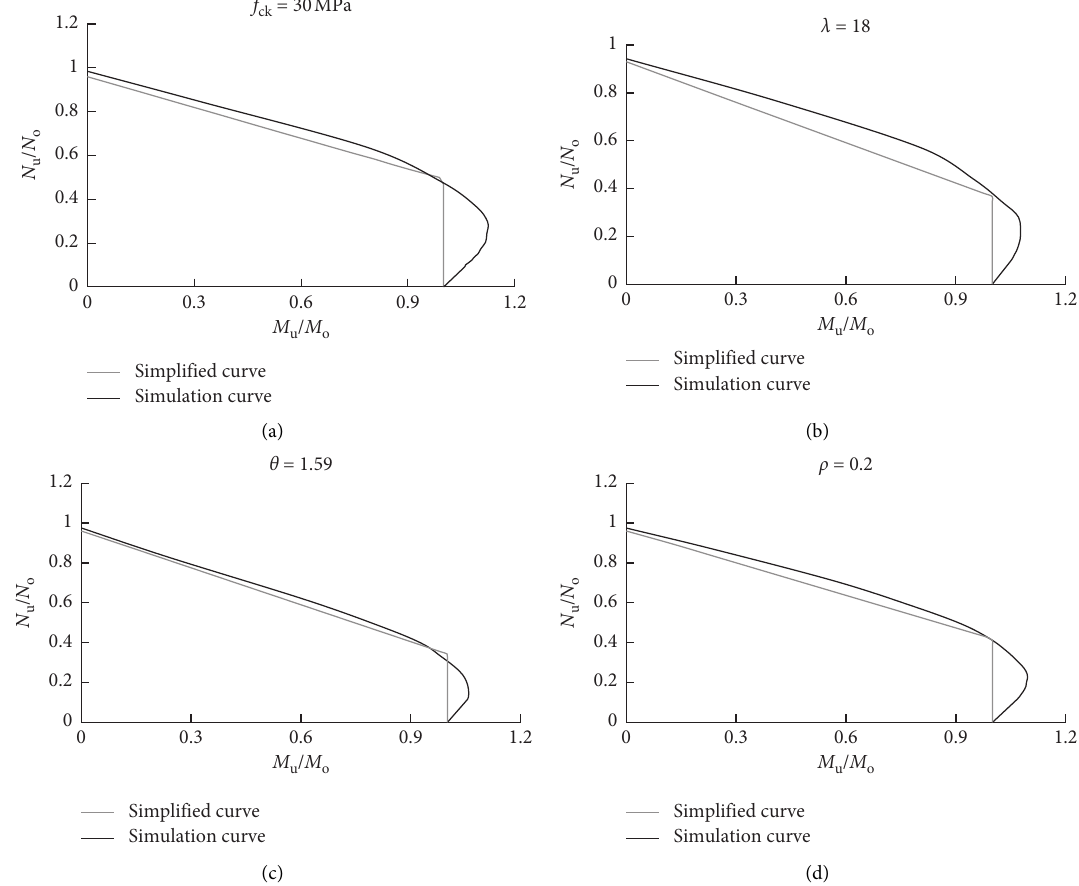
Figure 13: Comparisons between the fiber theoretical model and the simplified curves of N